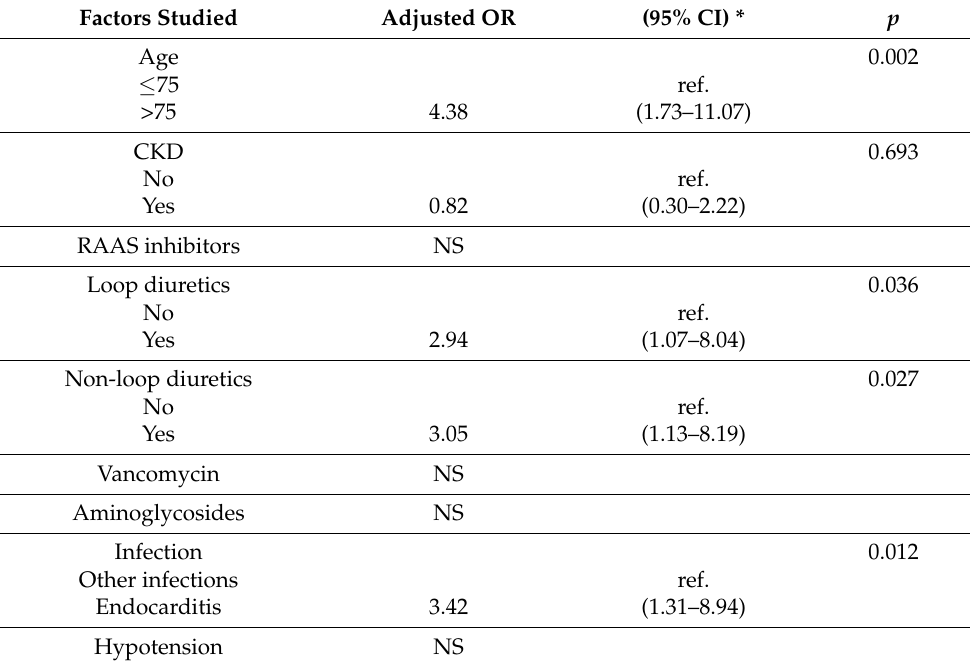
Table 4. Multivariate analysis of factors associated with AKI in the CLOX-AKI study (final model). Factors